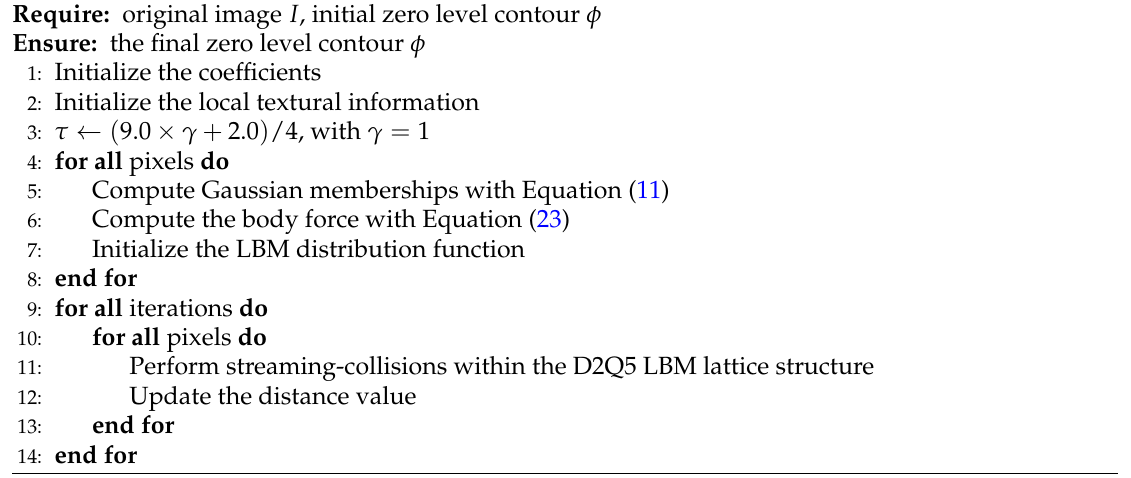
Algorithm 2 Pseudocode of the Loop Manipulation (LM)-optimized